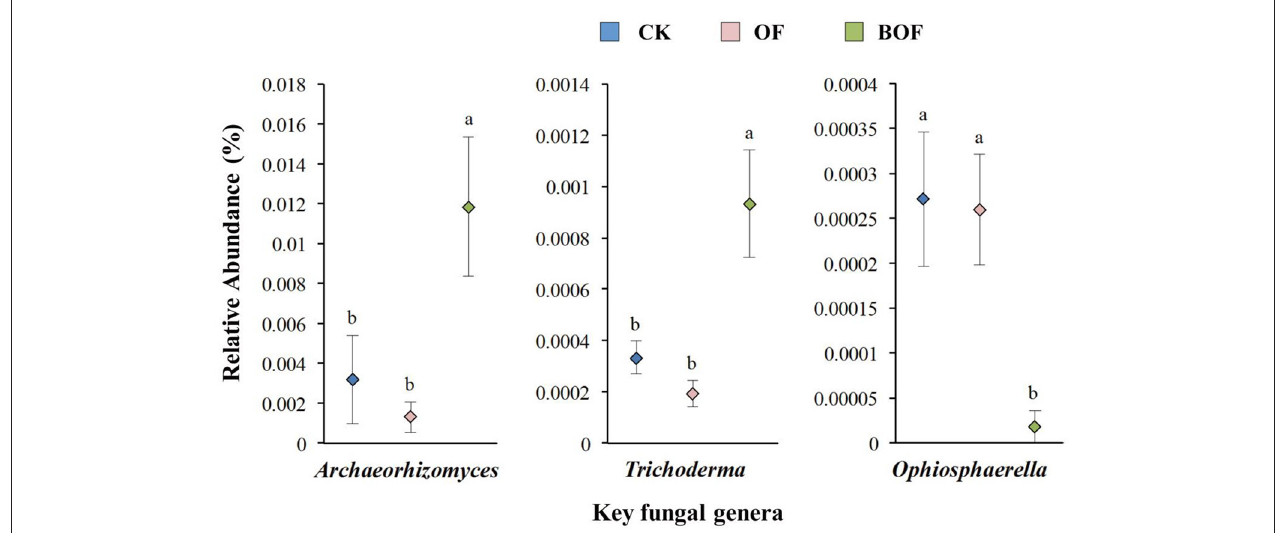
FIGURE 3 | Key fungal genera by fertilization regime. Y-axis scale for figures is based on relative abundance (%) range for different genera. CK (blue): non-amended; OF (pink): 9,000kg ha − 1 organic fertilizer (composted cattle manure); BOF (green): 9,000kg ha − 1 biofertilizer (composted cattle manure + Trichoderma inoculum). Diamonds and lines represent mean values of three replicates ± SE. Values that do not share a letter are significantly different ( p < 0.05).